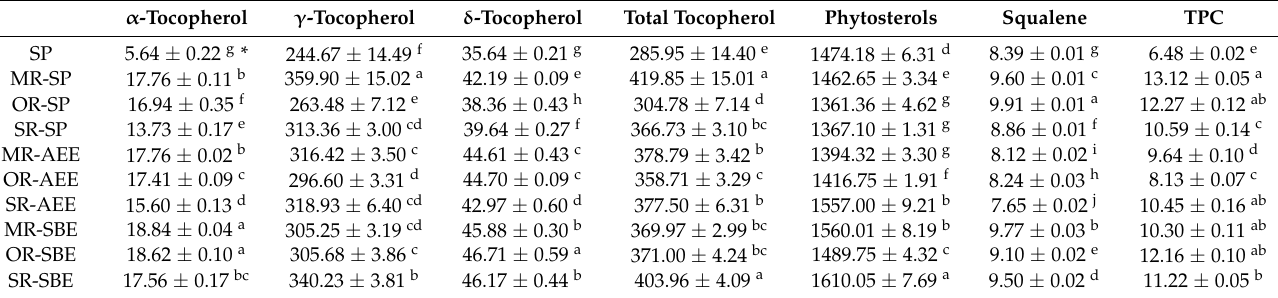
Table 2. The phytochemicals content (mg/kg) of walnut